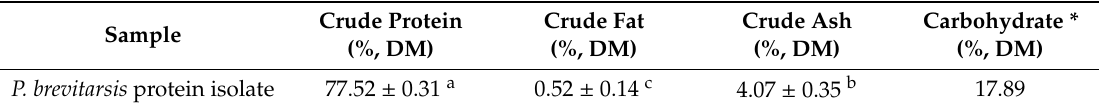
Table 2. Composition (g / 100 g) of the larva of Protaetia brevitarsis seulensis protein isolate (mean ± S.D., n = 3). The di ff erent letters in each column show a significant di ff erence (* p < 0.05) between means. Carbohydrate (%): 100 – crude protein – crude fat – crude